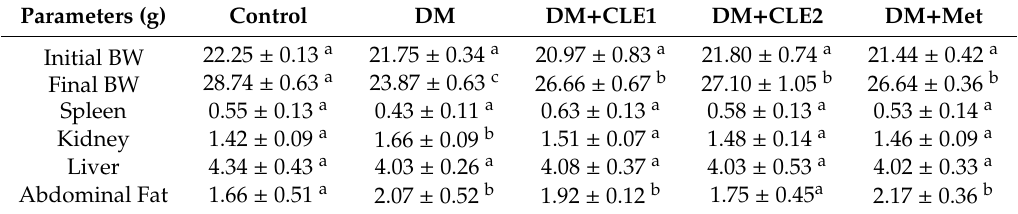
Table 1. Body weight and organ weight (% of body weight) of diabetic mice after treatment for 6 weeks. Parameters